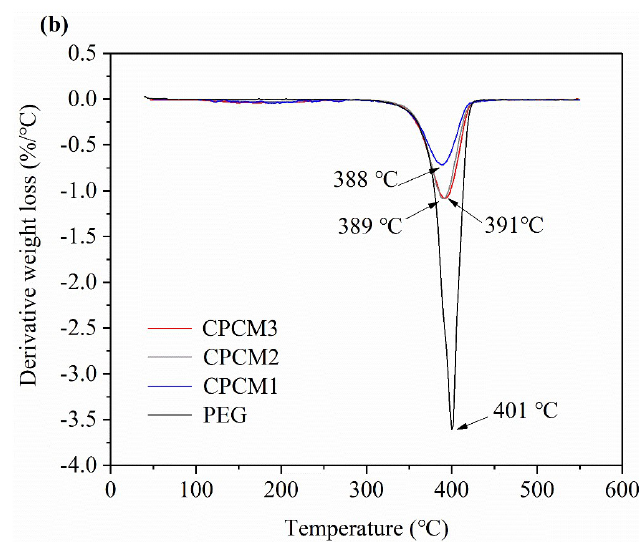
Figure 6. TGA curves of PEG and CPCM3 ( a ); Derivative weight loss (DTG) curves of PEG and CPCM3 ( b ).